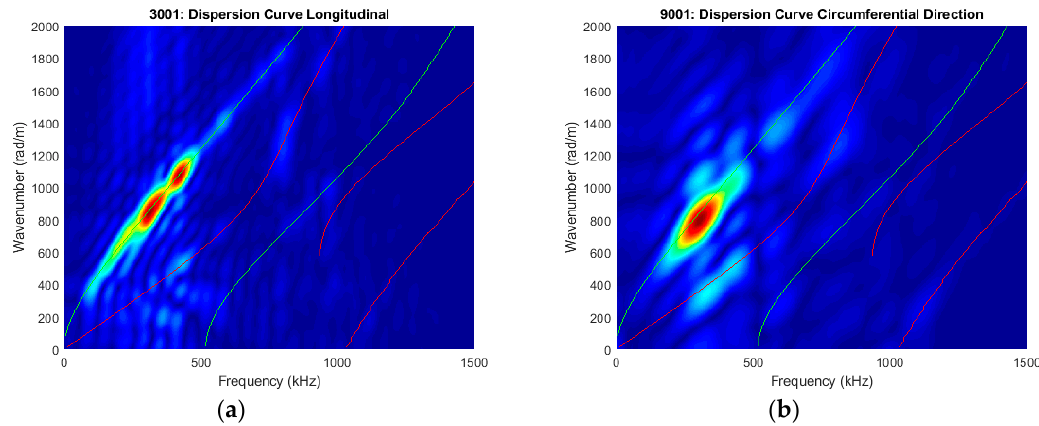
Figure 7. Experimental dispersion curves of a 1 MHz triangular pulse in the ( a ) longitudinal and ( b ) circumferential directions.